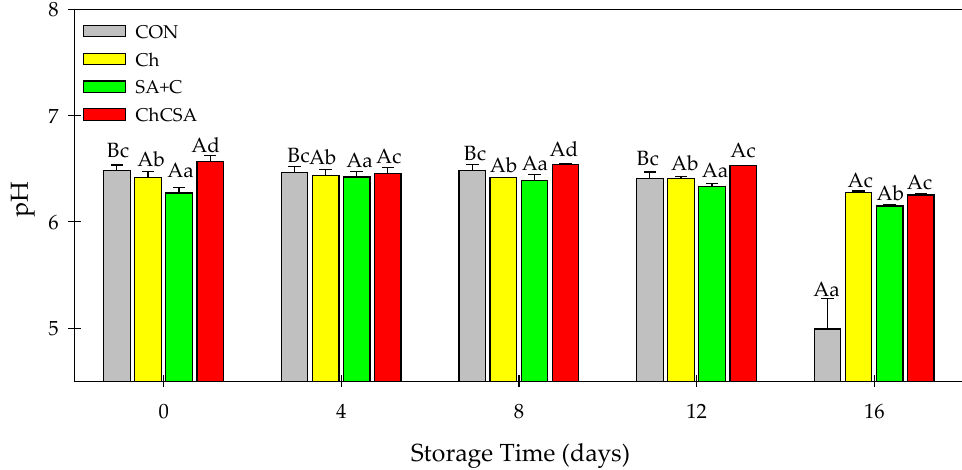
Storage Time (days) Figure 8. The effect of single-layer and gel coatings on the pH on fresh-cut purple sweet potato potatoes. Vertical bars represent means and standard deviation. Bars with different alphabets within the same storage day (lower case) or same treatment group at different storage days (upper case) are significantly different (Tukey’s HSD Test, p ≤ 0.05).